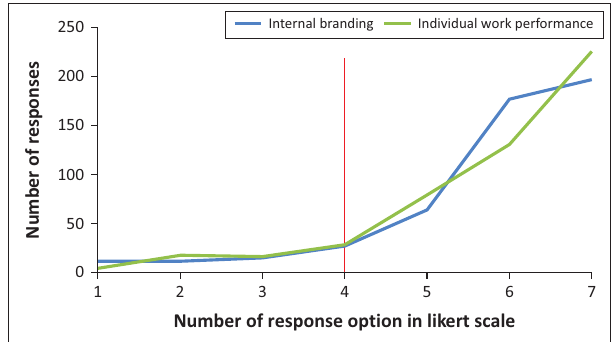
FIGURE 3: Adequacy of internal branding practices and level of individual work performance.